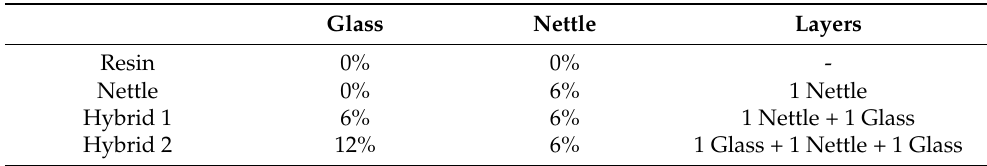
Table 1. Weight fraction of composites.